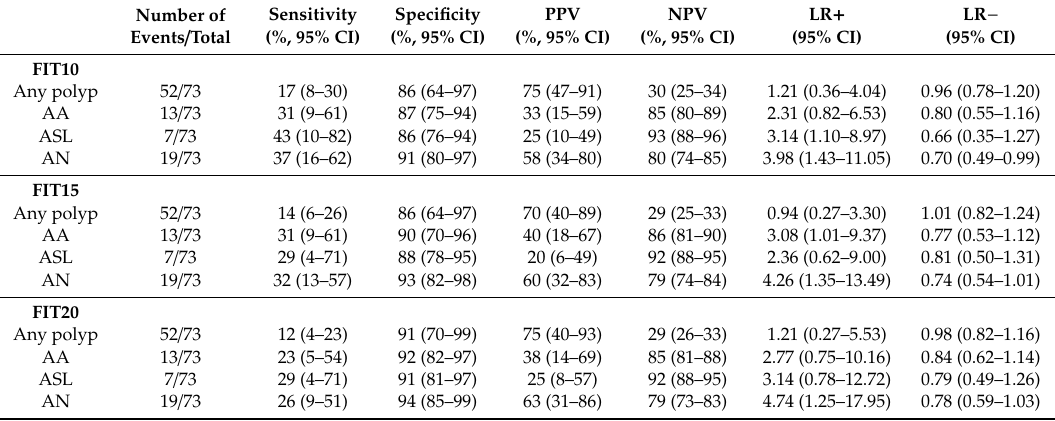
Table 2. Performance of fecal immunochemical test (FIT) at di ff erent cut-o ff levels for di ff erent disease